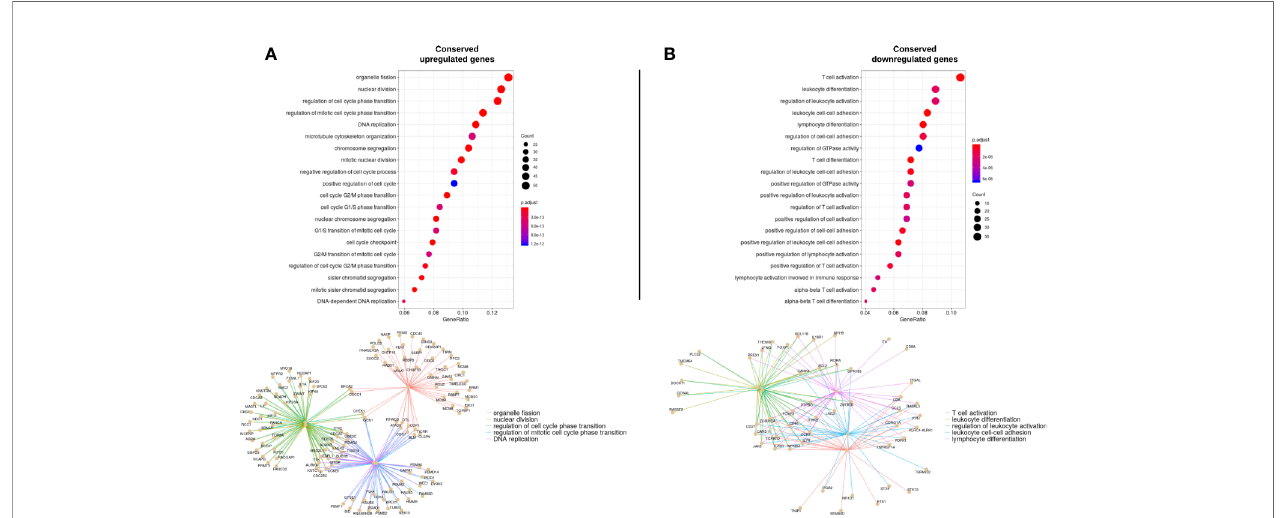
FIGURE 3 | Gene ontology enrichment analysis representing the enriched processes for up-regulated ( A , left column) and down regulated ( B ; right column) genes. The top 20 enriched processes are displayed. The size of each point represents the number of genes that enrich in the corresponding process. The x-axis value represents that number in the form of a gene-ratio. The lower part of each column represents the genes enriched in the top 5 processes and their functional